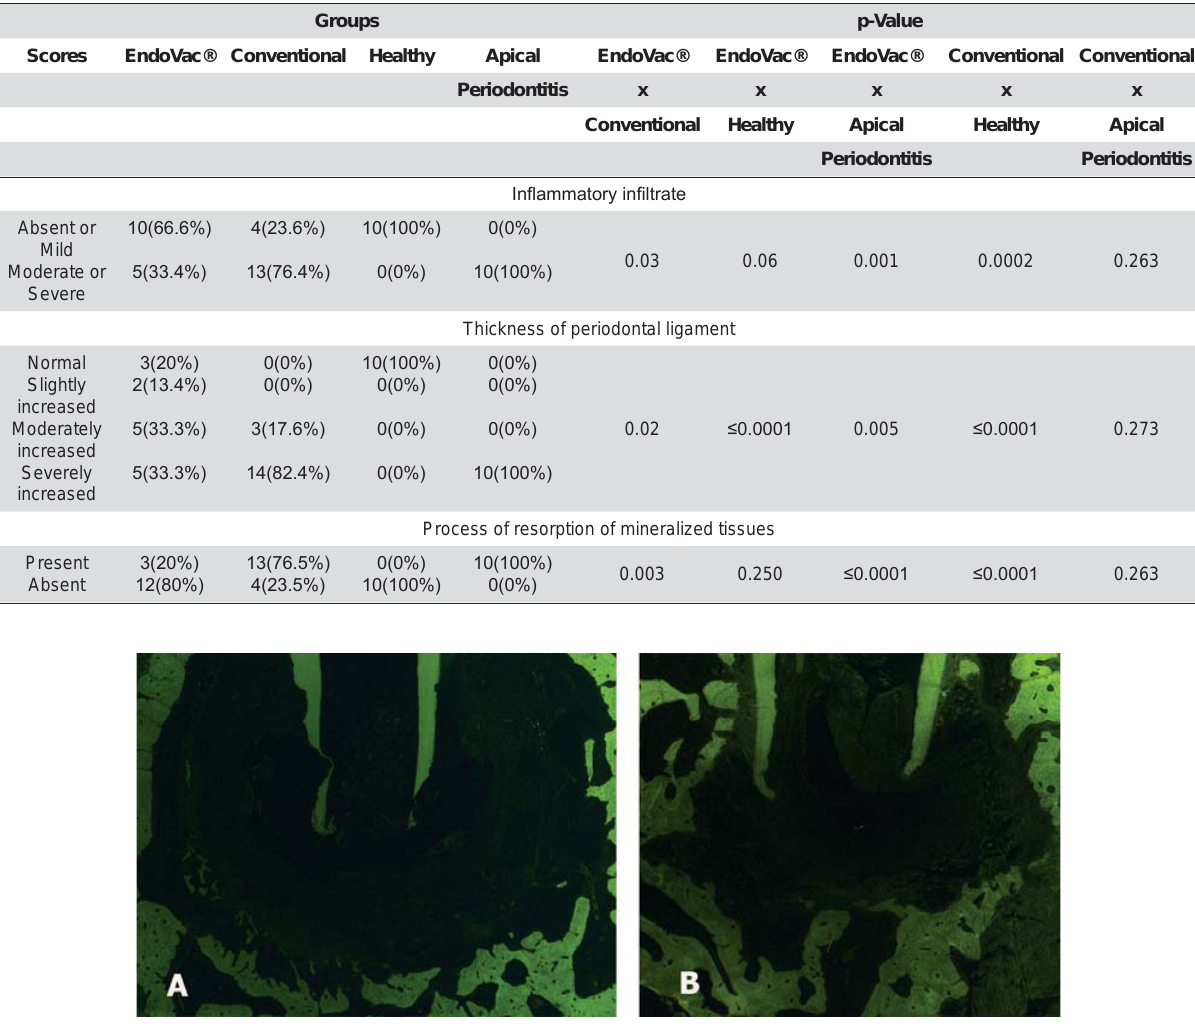
Table 1- (cid:3)(cid:53)(cid:72)(cid:86)(cid:88)(cid:79)(cid:87)(cid:86)(cid:3)(cid:73)(cid:82)(cid:85)(cid:3)(cid:44)(cid:81)(cid:192)(cid:68)(cid:80)(cid:80)(cid:68)(cid:87)(cid:82)(cid:85)(cid:92)(cid:3)(cid:76)(cid:81)(cid:191)(cid:79)(cid:87)(cid:85)(cid:68)(cid:87)(cid:72)(cid:15)(cid:3)(cid:87)(cid:75)(cid:76)(cid:70)(cid:78)(cid:81)(cid:72)(cid:86)(cid:86)(cid:3)(cid:82)(cid:73)(cid:3)(cid:83)(cid:72)(cid:85)(cid:76)(cid:82)(cid:71)(cid:82)(cid:81)(cid:87)(cid:68)(cid:79)(cid:3)(cid:79)(cid:76)(cid:74)(cid:68)(cid:80)(cid:72)(cid:81)(cid:87)(cid:15)(cid:3)(cid:68)(cid:81)(cid:71)(cid:3)(cid:85)(cid:72)(cid:86)(cid:82)(cid:85)(cid:83)(cid:87)(cid:76)(cid:82)(cid:81)(cid:3)(cid:82)(cid:73)(cid:3)(cid:80)(cid:76)(cid:81)(cid:72)(cid:85)(cid:68)(cid:79)(cid:76)(cid:93)(cid:72)(cid:71)(cid:3)(cid:87)(cid:76)(cid:86)(cid:86)(cid:88)(cid:72)(cid:3)(cid:69)(cid:72)(cid:87)(cid:90)(cid:72)(cid:72)(cid:81)(cid:3)(cid:87)(cid:75)(cid:72)(cid:3)(cid:74)(cid:85)(cid:82)(cid:88)(cid:83)(cid:86)